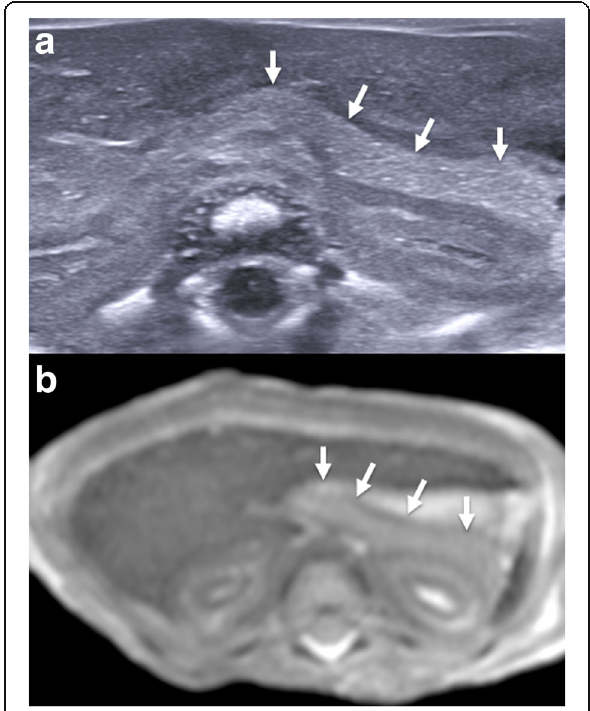
Fig. 17 Normal appearances of the pancreas (white arrows) on transverse postmortem ultrasound ( a ) in a 20-week gestational-aged foetus, 4 days after death with corresponding postmortem T2- weighted MRI at 1.5 T ( b ) obtained 12 days after